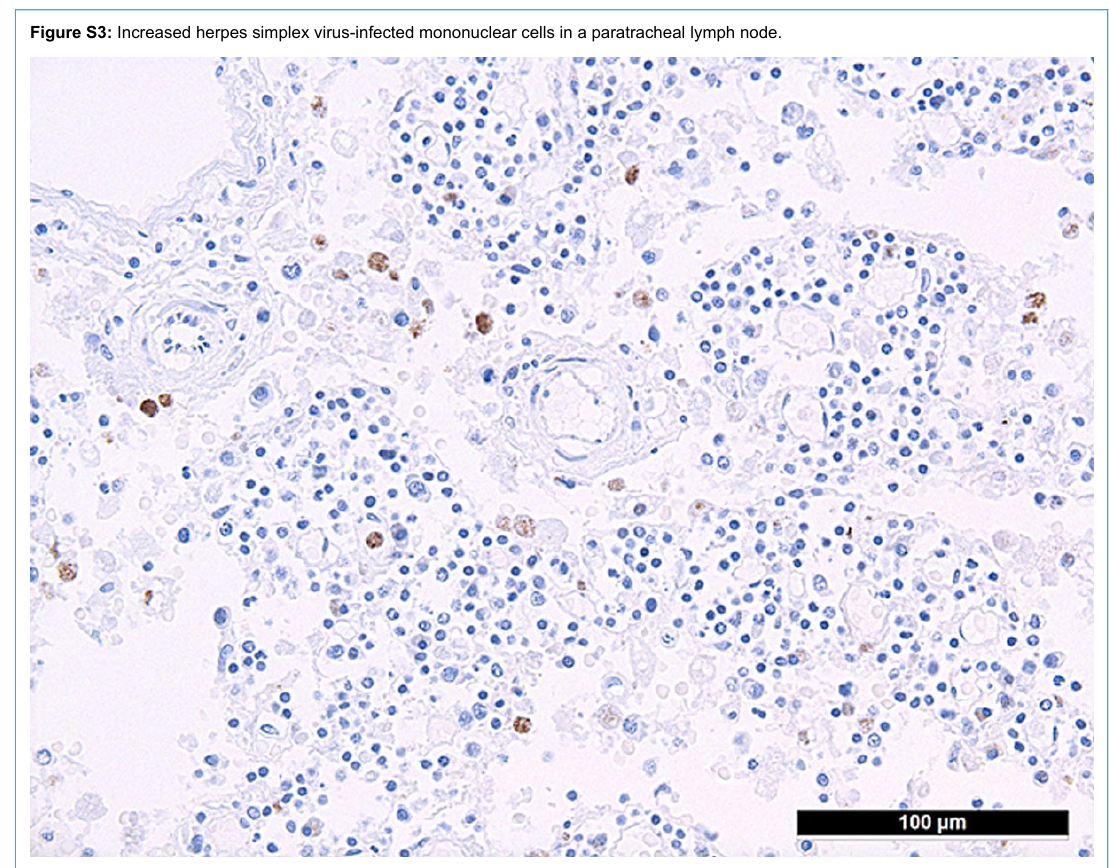
Figure S3: Increased herpes simplex virus-infected mononuclear cells in a paratracheal lymph